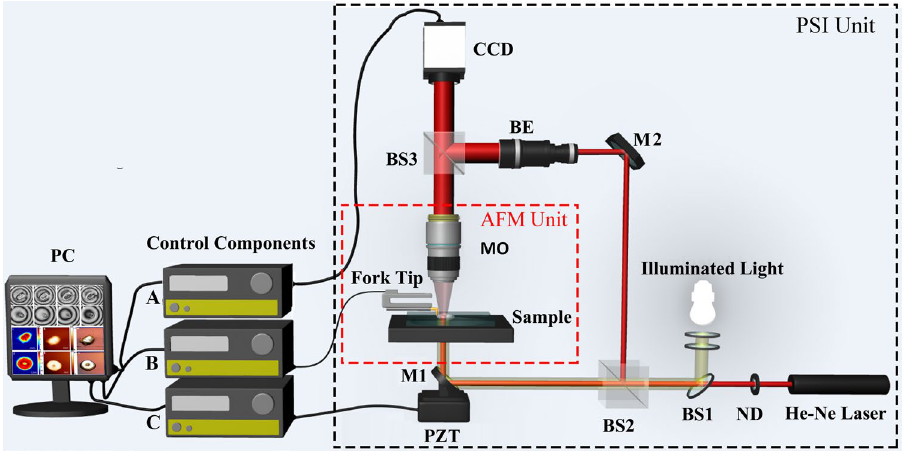
Figure 1. Schematic of PSI/AFM based refractive index measurement system, in which AFM (MultiView 4000, Nanonics, Israel) was equipped with an Olympus BX51 microscope, PSI unit was attached to the microscope. BS1, BS2, BS3: beam splitter; ND: neutral density filter; MO: microscopic objective; BE: beam expander; PZT: piezoelectric ceramics transducer; M1, M2: mirror; Control Components ( A ) Phase-shifting interferogram acquirement; ( B ) AFM scanning control and morphological information acquirement; ( C ) Phase-shifting